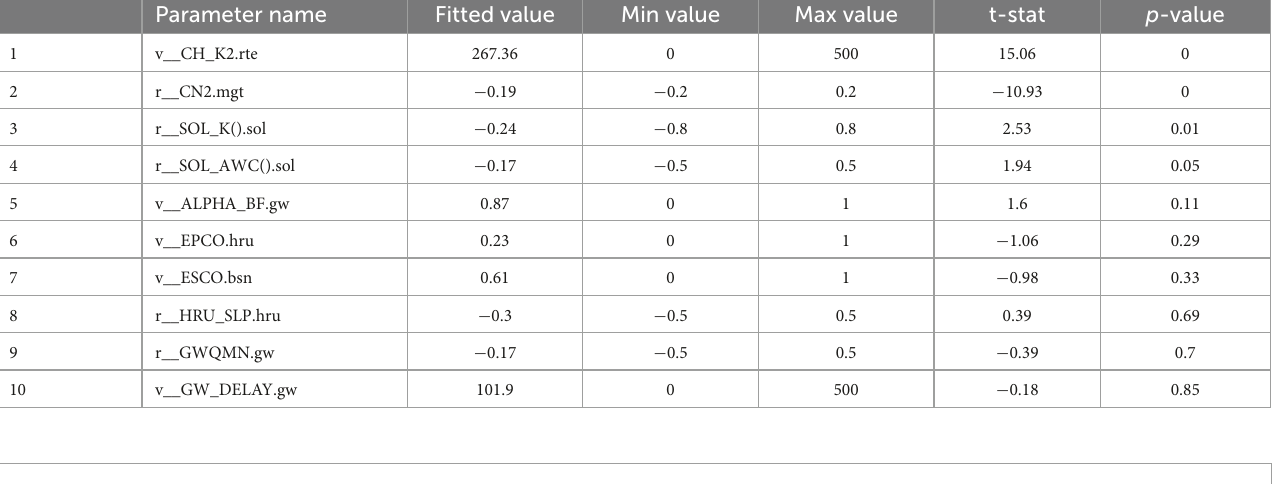
TABLE 6 Best parameters and their sensitivity ranking.